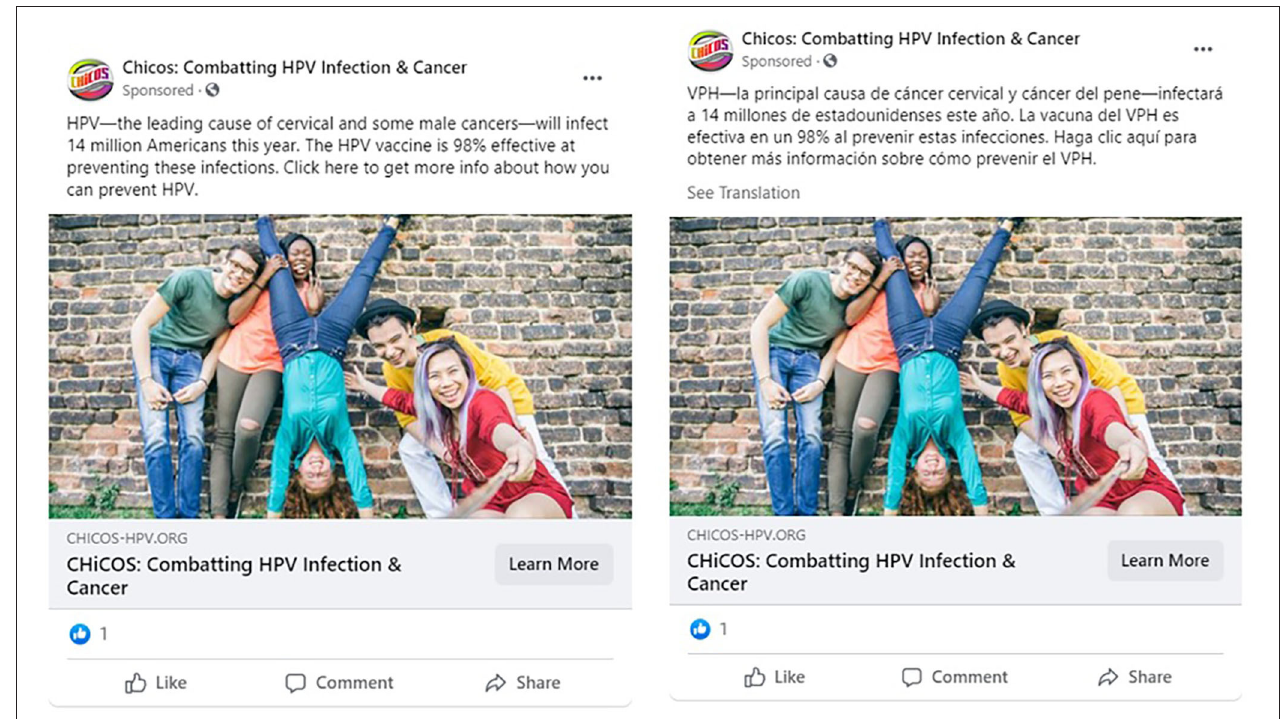
FIGURE 2 | Example of facebook